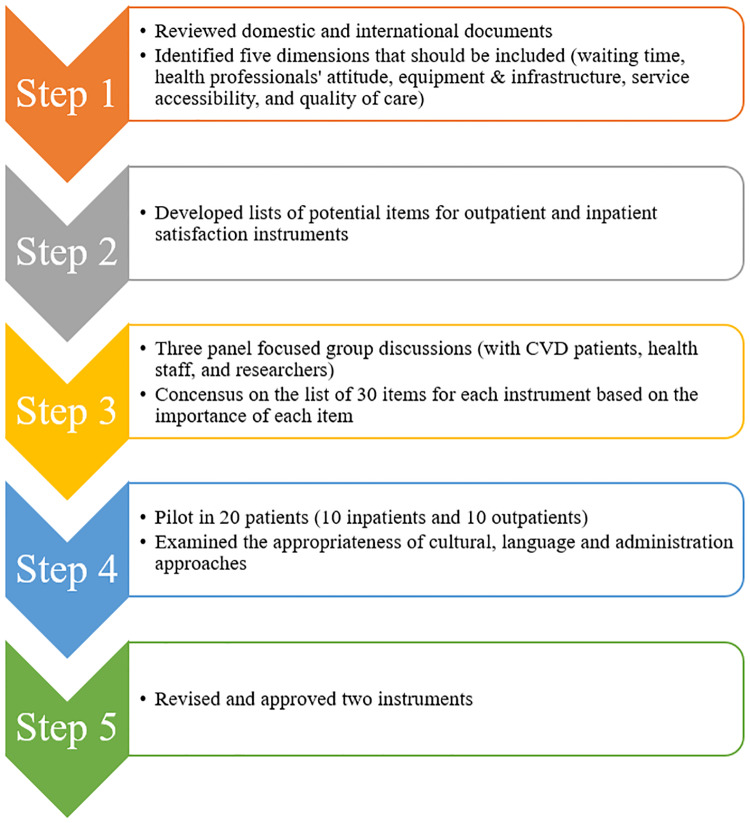
Tool development process.